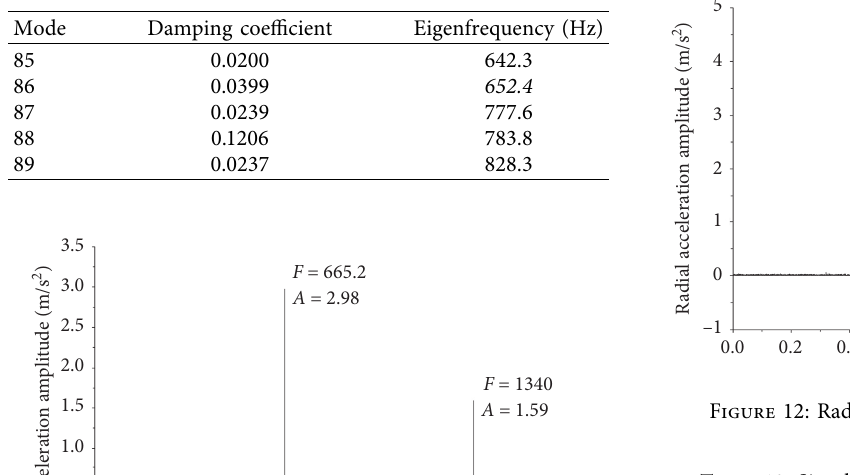
Table 12: Optimal eigenfrequencies (segmental).